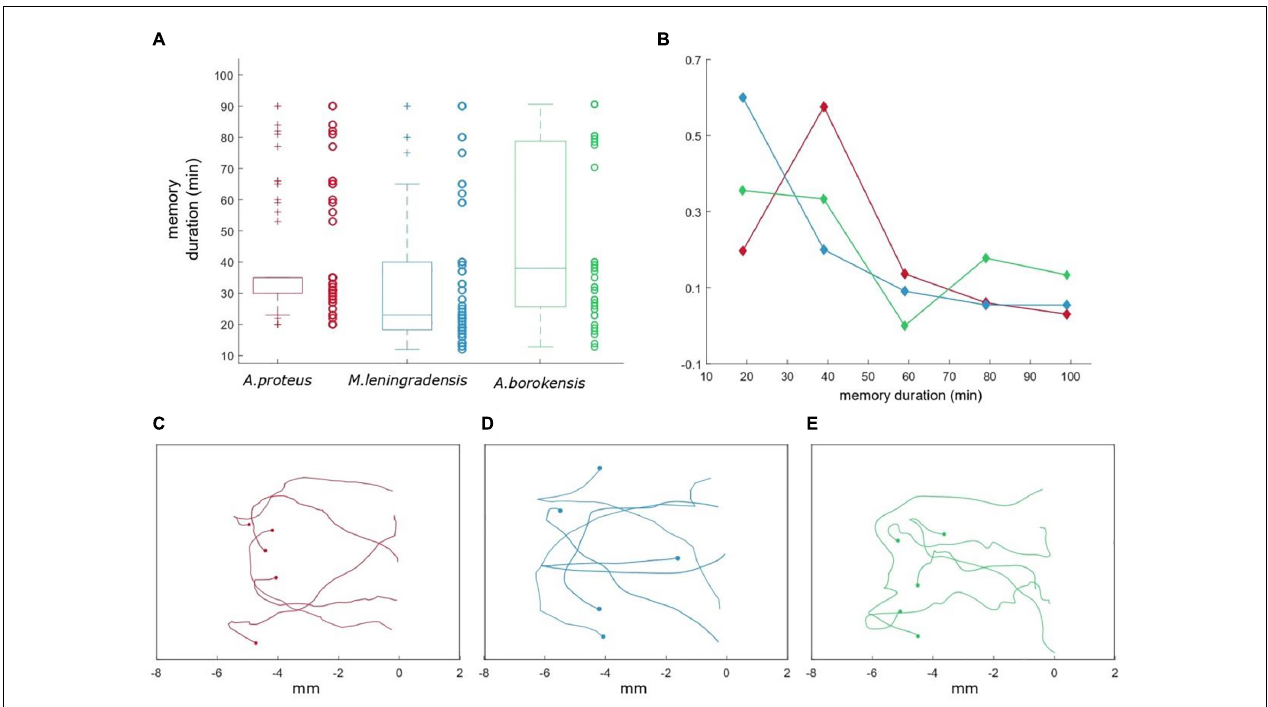
FIGURE 7 | Persistence time for the cells that acquired conditioned behavior. (A) Boxplot representing the duration of the acquired associative behavior (up to 90 min) for the three species ( A. proteus in red, M. leningradensis in blue, and A. borokensis in green). On the side of each box, we depict the persistence time values with circles. (B) Frequency polygons representing the duration for each species. The x -axis indicates the duration in minutes, while the y -axis represents the relative frequency for the three cell types. As it can be observed, the majority of the cells present persistence times ranging between 20 and 50 min. Panels (C–E) show how the trajectories of 15 prototypical amoebae (belonging to A. proteus, M. leningradensis , and A. borokensis ) after the induction process lost gradually the persistence toward the anode and turned back to the cathode, under new galvanotaxis conditions. Here, the x -axis indicates the distance traveled in